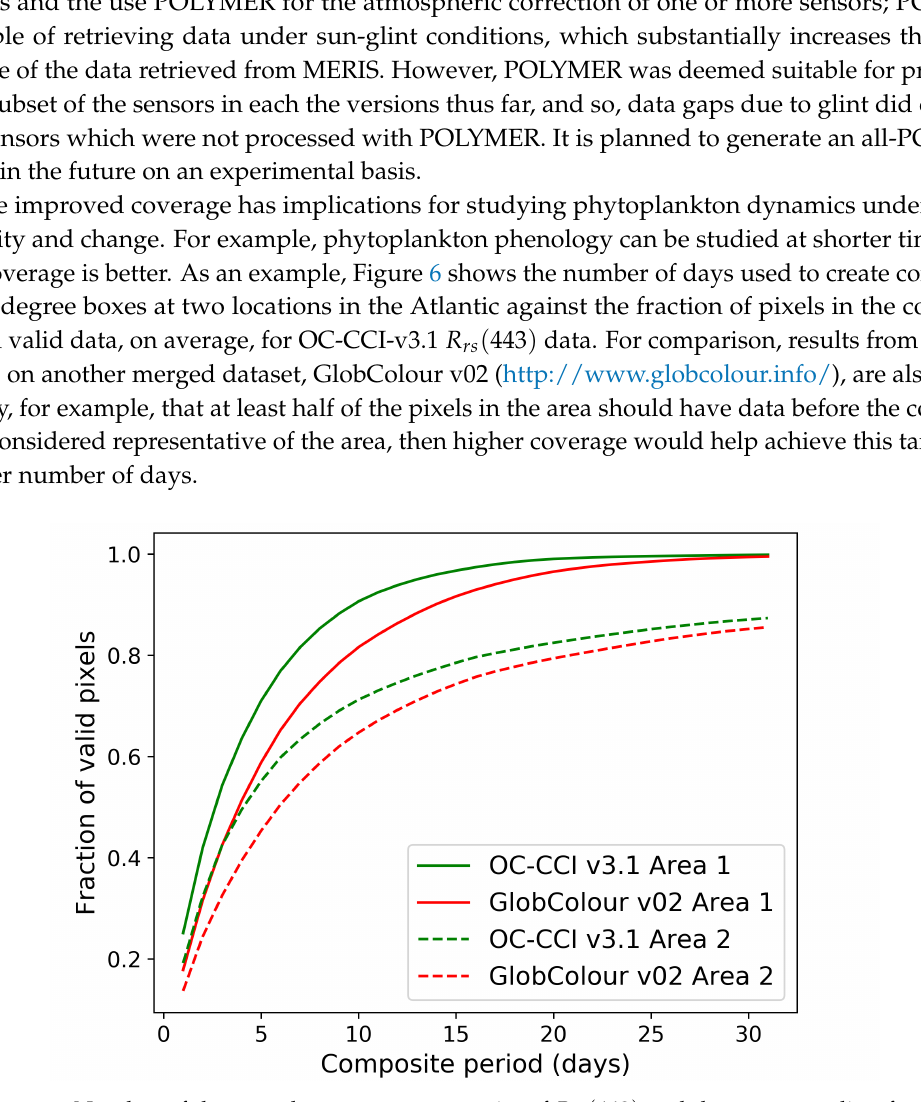
Figure 6. Number of days used to create a composite of R rs ( 443 ) and the corresponding fraction of valid pixels in the composite for two sites in the Atlantic: The average for the 2003–2010 period. Area one (continuous lines): one-degree box centred on 41 ◦ N and 40 ◦ W; area 2 (dashed lines): 11 ◦ S and 4 ◦ E. Green lines: OC-CCI-v3.1 product; red lines: GlobColour product.